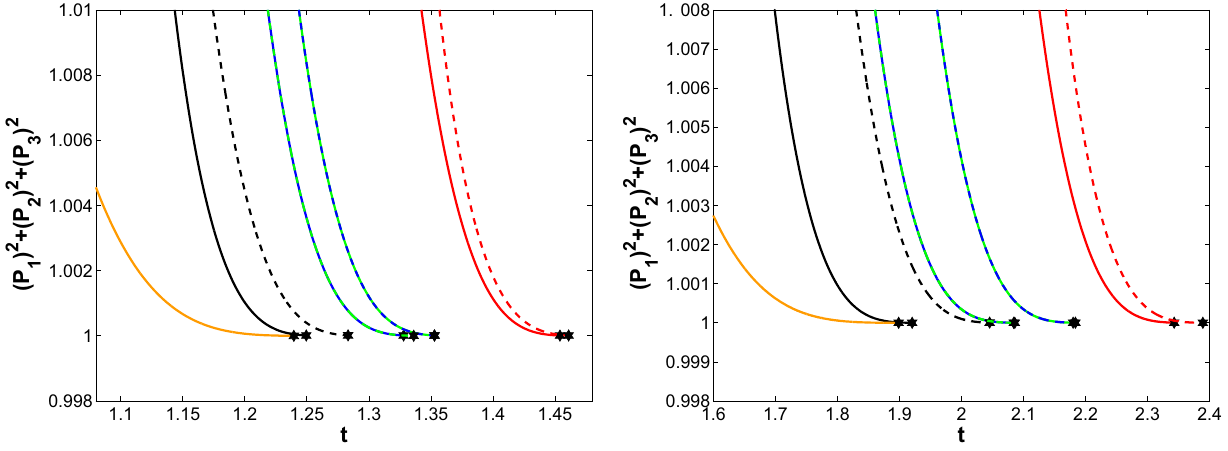
Fig. 4 The final part of the evolution of the sum ( P 1 ) 2 + ( P 2 ) 2 + ( P 3 ) 2 for N = 2, f 0 = 1 of H a ( 0 ) , H b ( 0 ) are chosen as in Fig. 1 (see the corresponding colors and types of line). The black star denotes the moment of a cosmological